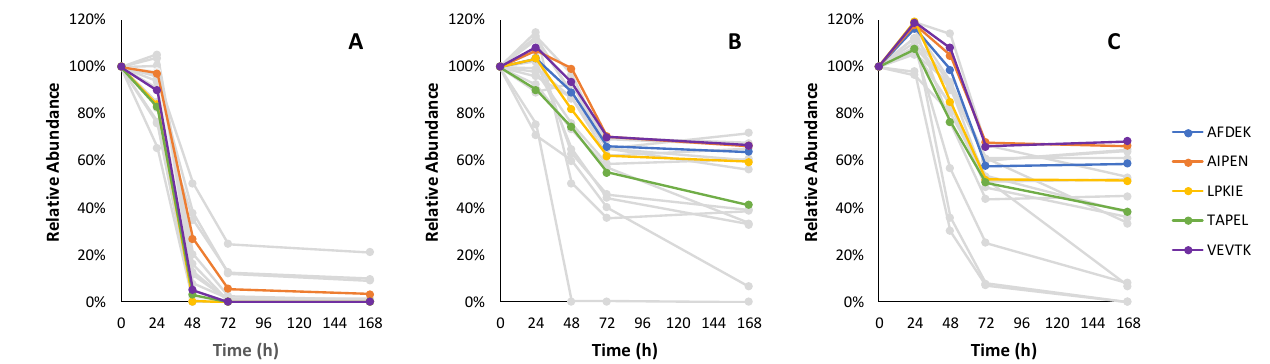
Figure 6. The relative consumption trends of 19 pentapeptides in fermentation with Lalvin ICV Opale 2.0™ ( A ), Lalvin Persy™ ( B ) and Lalvin QA23™ ( C ) of the modified synthetic must with added BSA hydrolysate as the peptide source. The five pentapeptide candidates with the highest abundance are shown in colour. Other pentapeptide candidate sequences and their observed relative consumption trends are shown in Table A7.